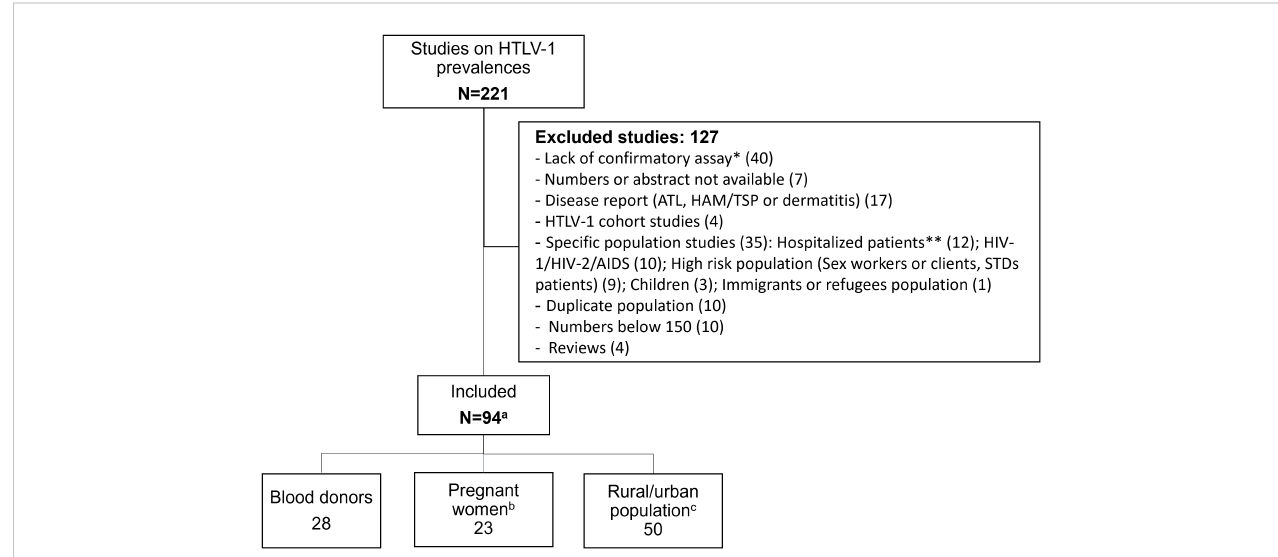
FIGURE 2 Flow chart of manuscript screened for prevalence of HTLV-1 in blood donors, pregnant women and rural or urban adult population, living in Africa. * Two studies lacking con fi rmatory assay but showing 0% HTLV-1 seroprevalence with ELISA were included and were not counted in this line. ** Hospitalized patients included neurological, hematological, malignant, Kaposi, Leprosy patients and other. (a) Numbers in each study population category do not add up as some studies had data on different populations (blood donors, pregnant women and urban or rural adult population). These studies were counted in each category. (b) Two studies on healthy mothers were included. (c) Two studies on rural out-patients, presenting no severe pathology were included and considered as rural